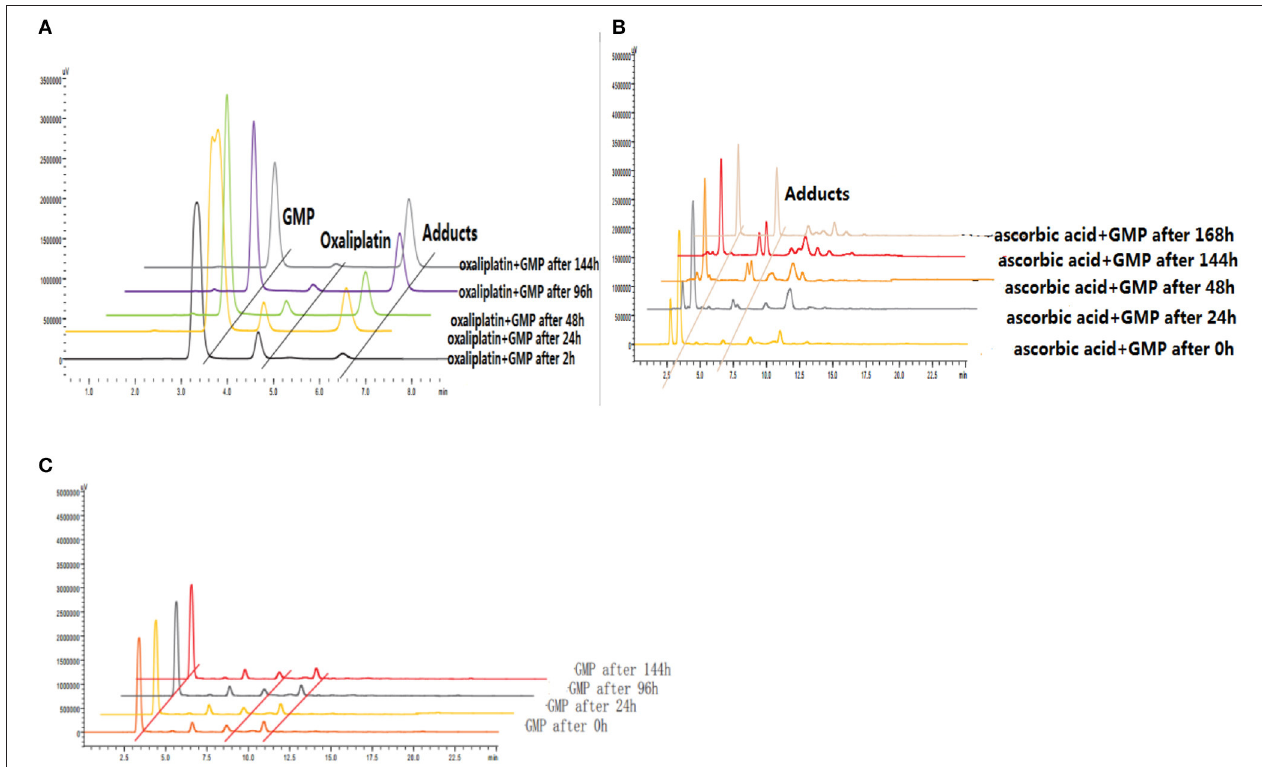
FIGURE 8 | (A) Reduction and DNA-binding properties of oxaliplatin after 2, 24, 48, 96, and 144h. (B) Reduction and DNA-binding properties of 6d with ascorbic acid after 0, 24, 48, 144, and 168h. (C) Reduction and DNA-binding properties of 6d without ascorbic acid after 0, 24, 96, and 144h.